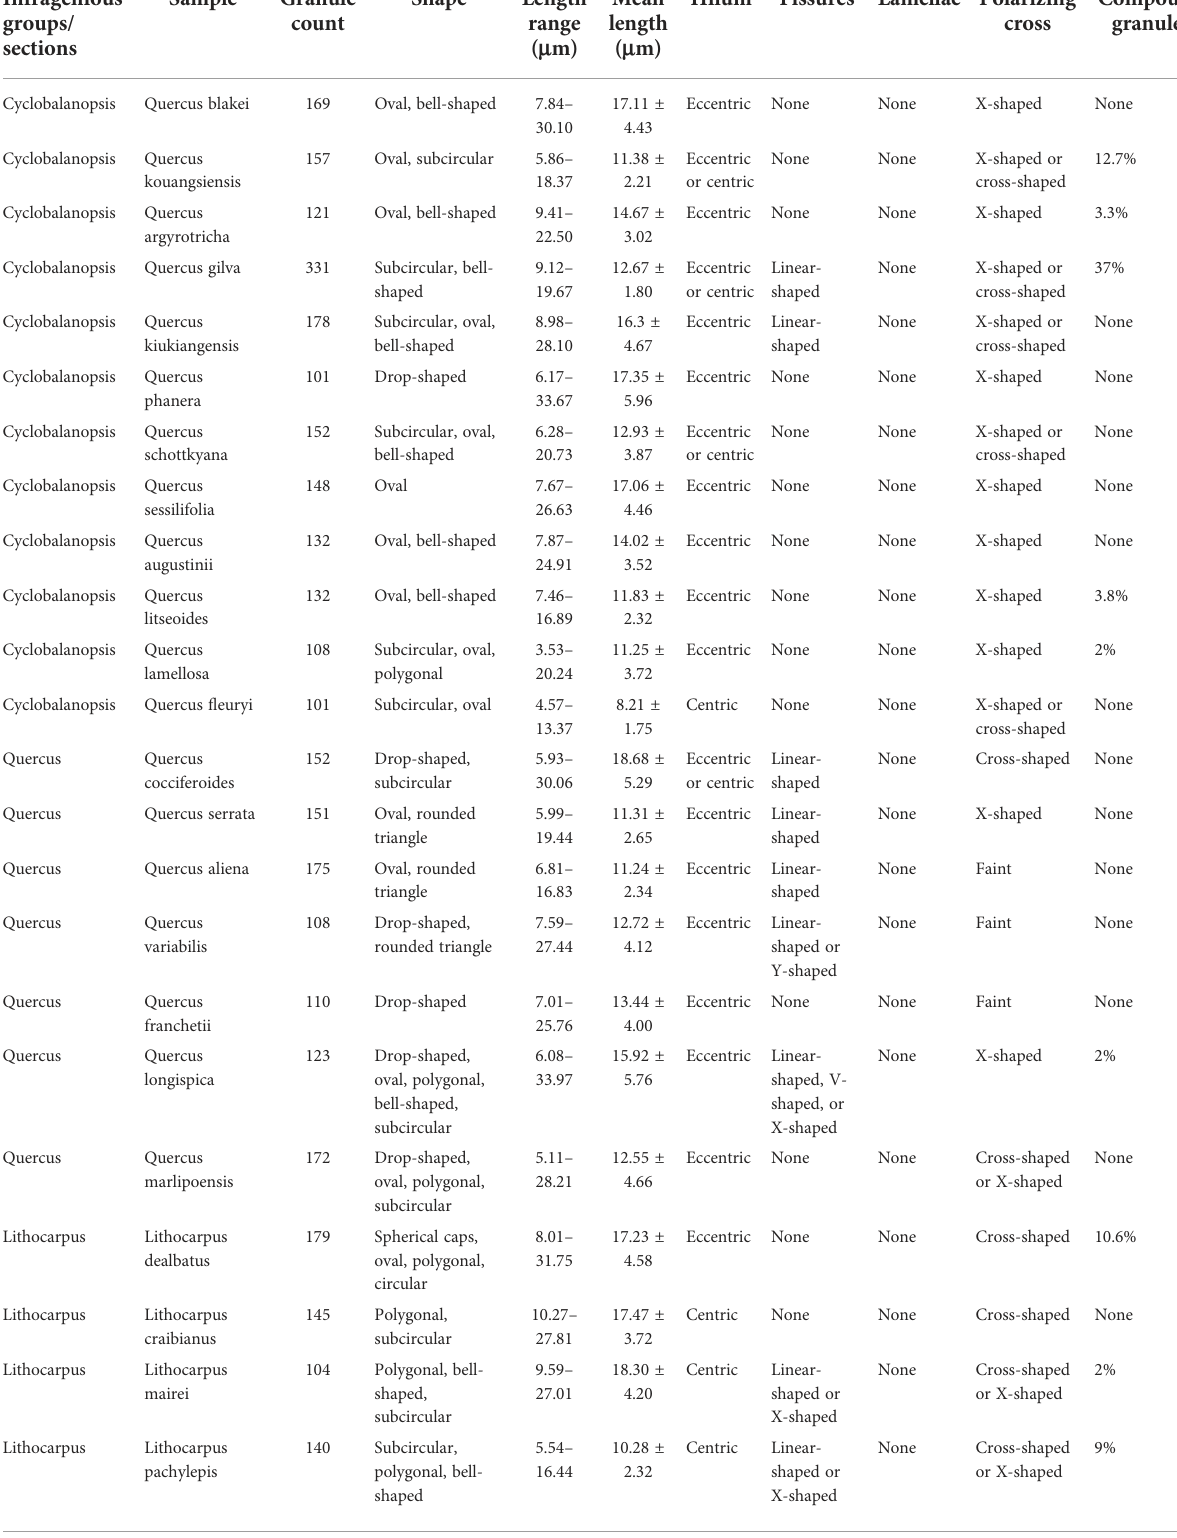
TABLE 1 Summary of starch granule dimensions and morphological features in 34 species from